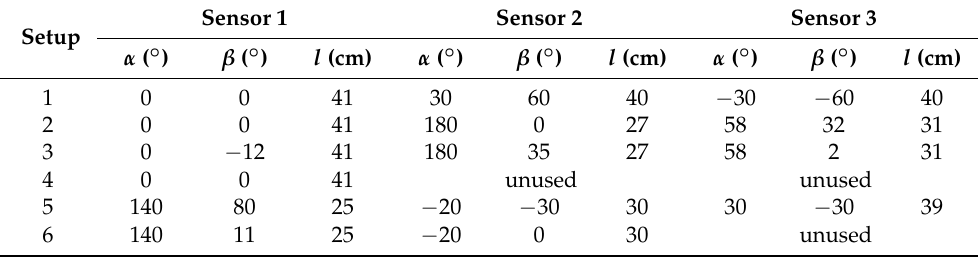
Table 2. Experimental mobile platform multi-sonar